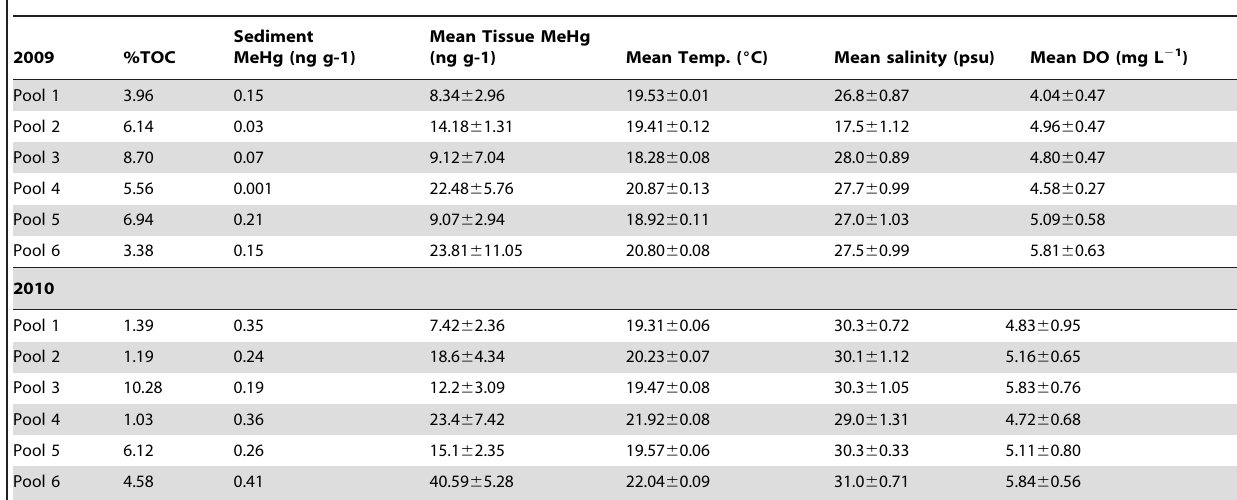
Table 2. Environmental parameters, % TOC, methylmercury concentrations in sediment and tissue of Fundulus heteroclitus from salt marsh